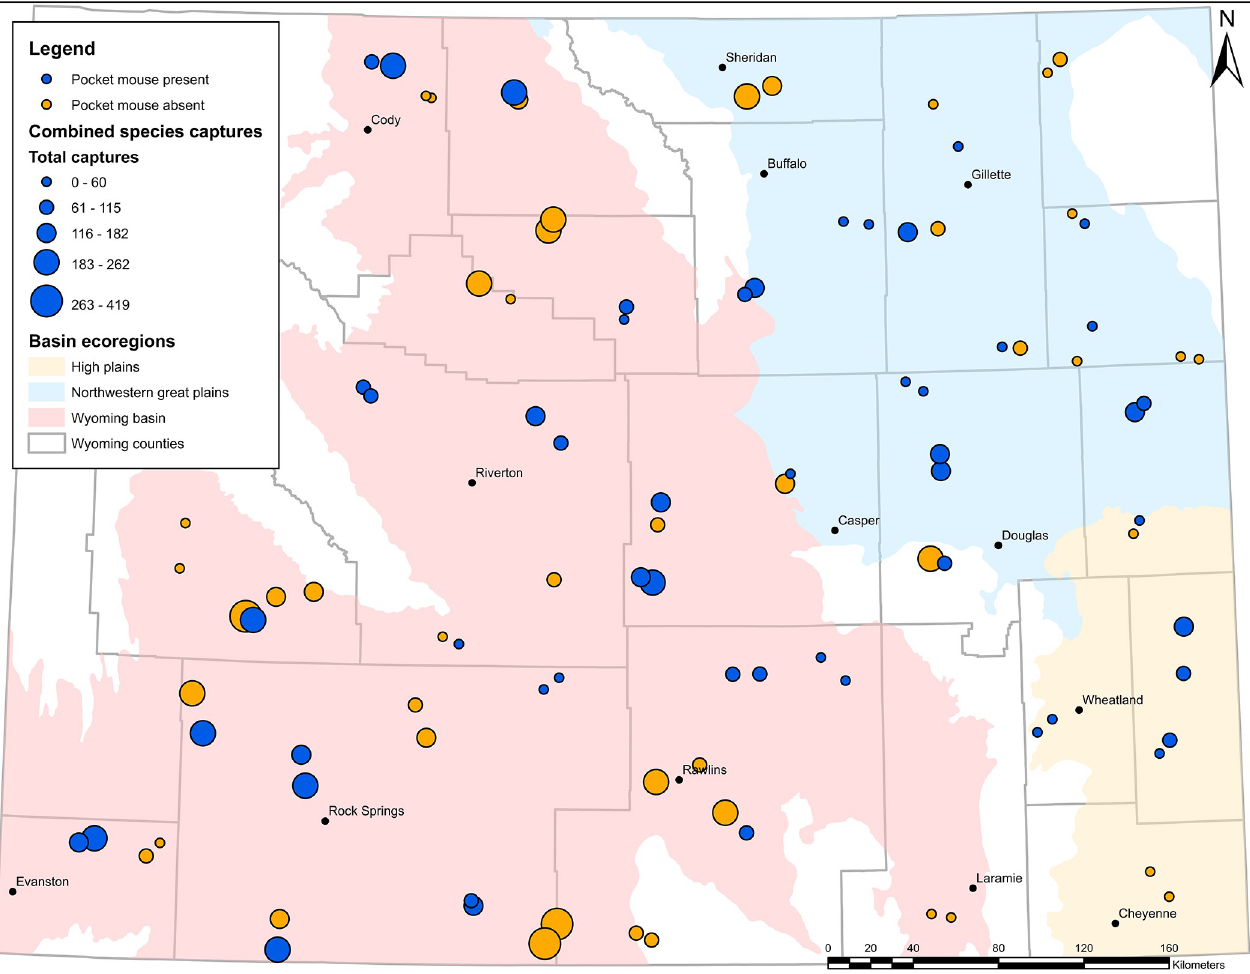
Fig 1. Trapping locations for both 2015 and 2016 across Wyoming sagebrush shrubland and prairie grassland. Total captures for all species shown in different sizes. Trapping sites where pocket mice were present are in blue. Sites where pocket mice were not detected are in orange.